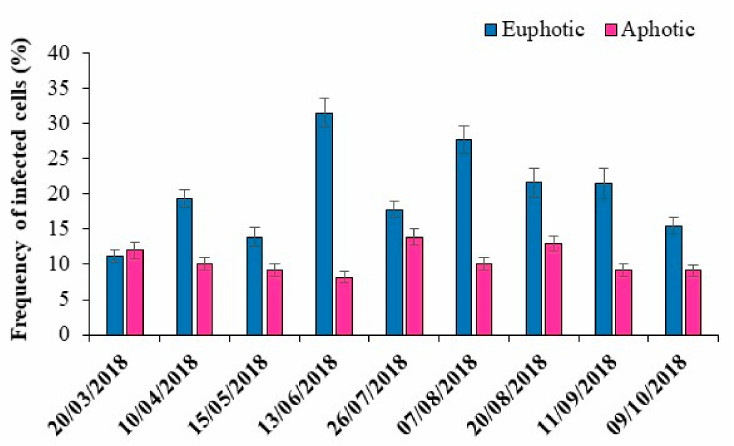
Figure 3. Time series variations in frequency of viral-infected bacterial cells (FIC) at euphotic and aphotic zones in Lake Goule. Data represent mean ± SE ( n =